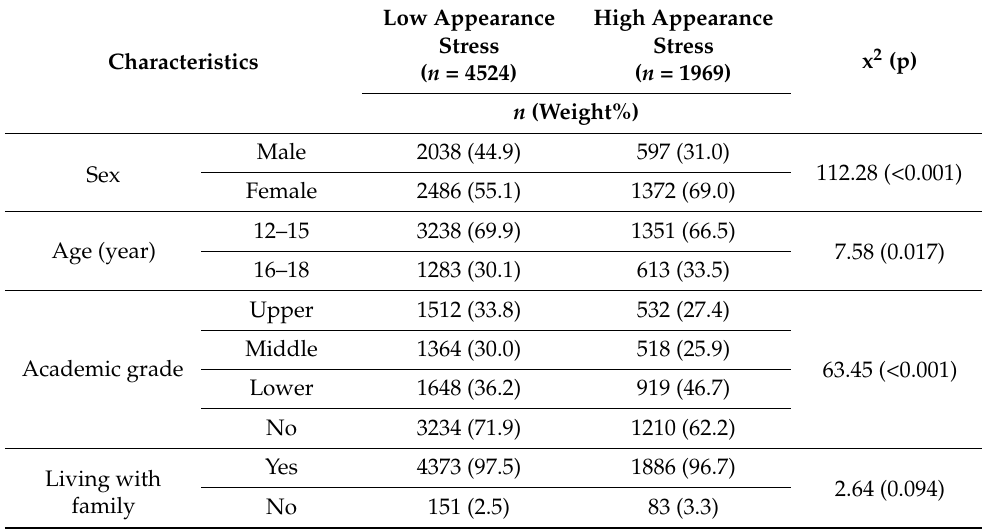
Table 1. Sociodemographic factors ( n =